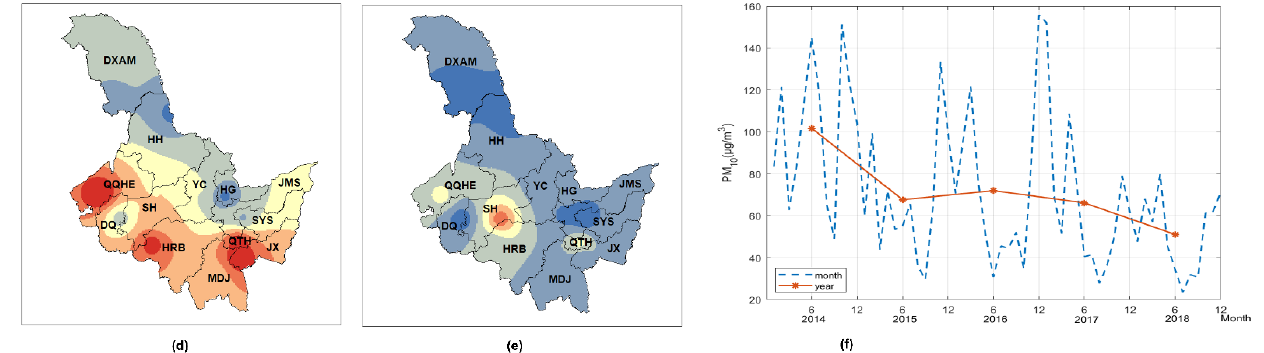
Figure 6. The spatial and temporal distribution of PM 10 ( μ g/m 3 ) in Heilongjiang Province from 2014